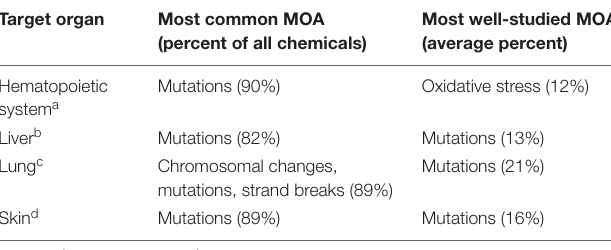
TABLE 2 | Results from the classification of abstracts relevant to carcinogenesis. Target organ